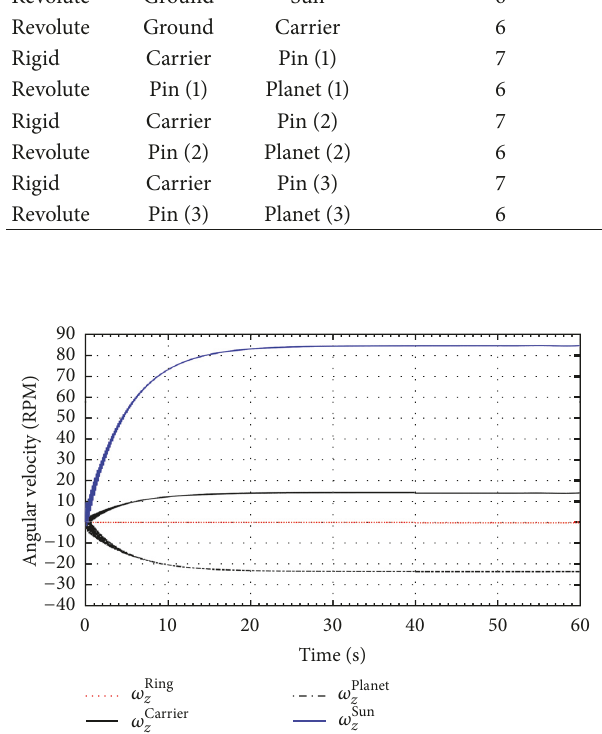
Figure 8: Angular speed of gears in planetary stage.